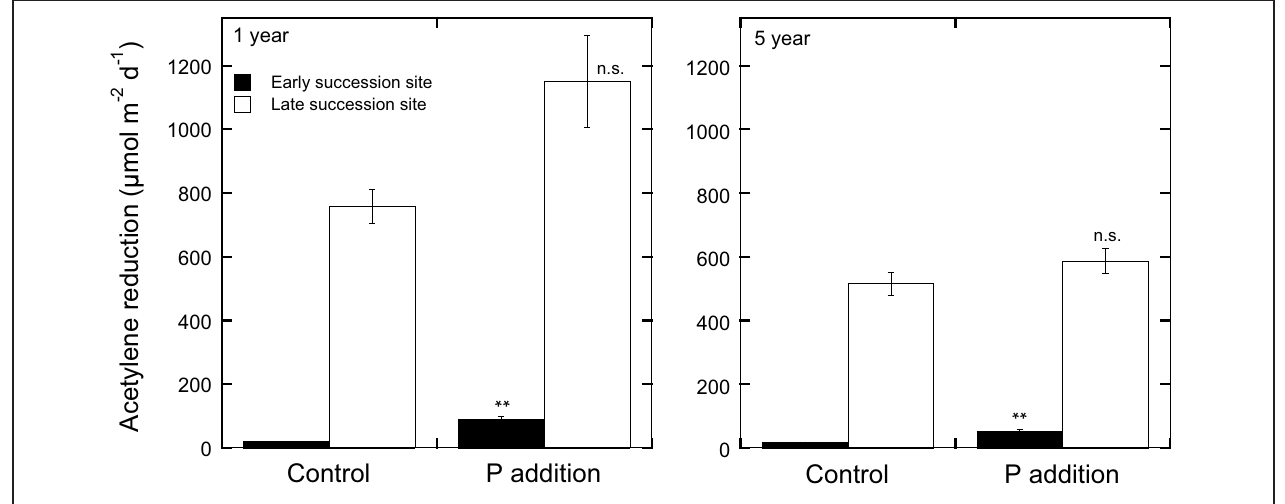
FIGURE 3 | Acetylene reduction rates ( µ molm − 2 d − 1 ) in Pleurozium schreberi at one late (open bars) and one early (filled bars) succession forest site in northern Sweden in response to P additions (5kg P ha − 1 yr − 1 as NaH 2 PO 4 ). Shown are acetylene reduction rates measured 1 and 5 years after the P additions. Phosphorus was applied annually to 10 replicate